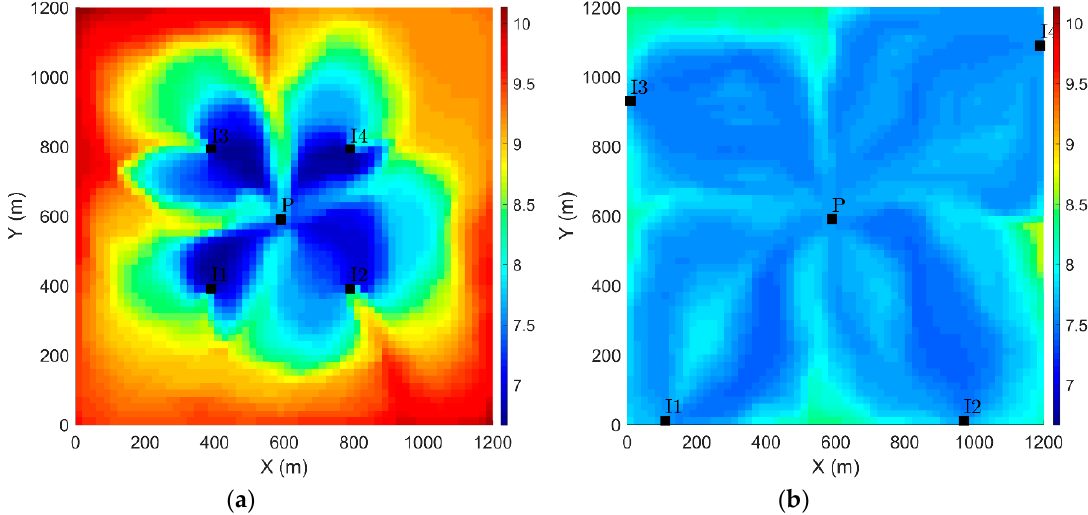
Figure 7. Simulated distributions of the residence time, in Log 10 scale, for the ( a ) initial and ( b ) optimal well designs in the two-dimensional heterogeneous aquifer. Initial and optimal positions of the wells are also shown in the corresponding figures.